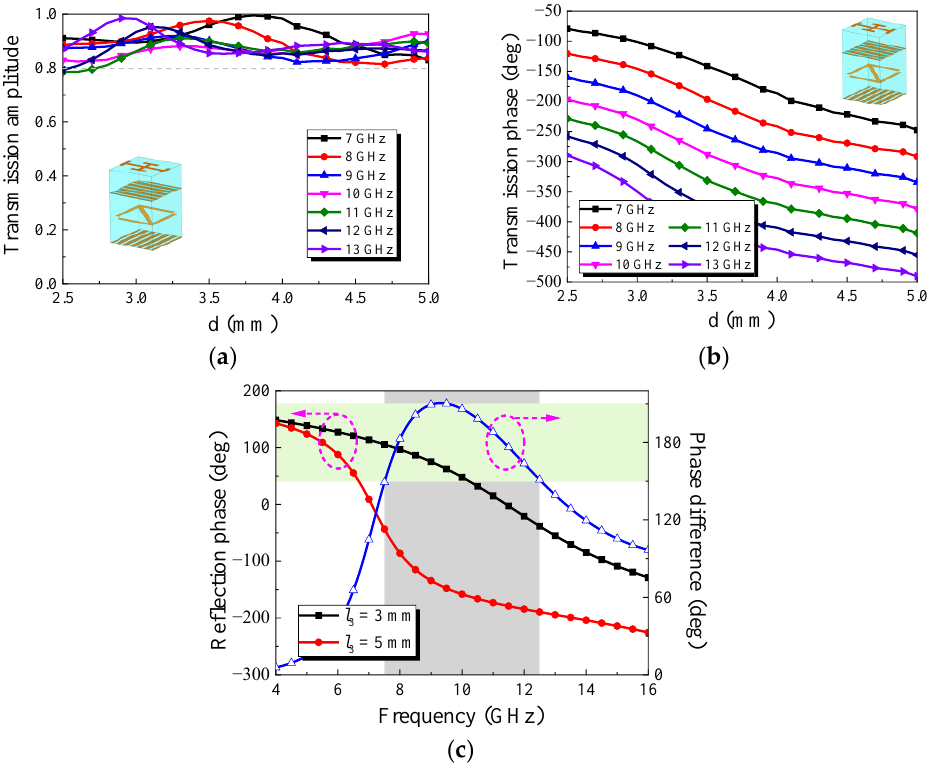
Figure 9. Simulation results of the element: ( a ) transmission amplitude; ( b ) transmission phase; ( c ) reflection phase of the y -polarized incident wave.